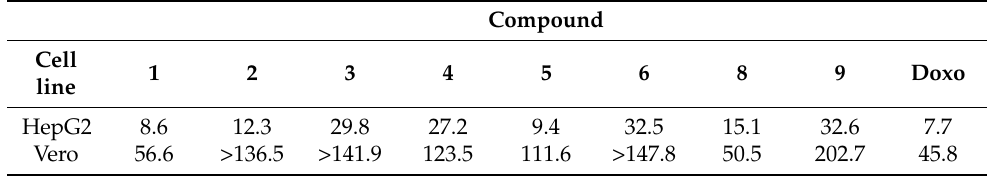
Table 2. In vitro cytotoxic effects (IC 50 , μ M) of compounds 1 – 6 , 8 and 9 on HepG2 and Vero cell lines.